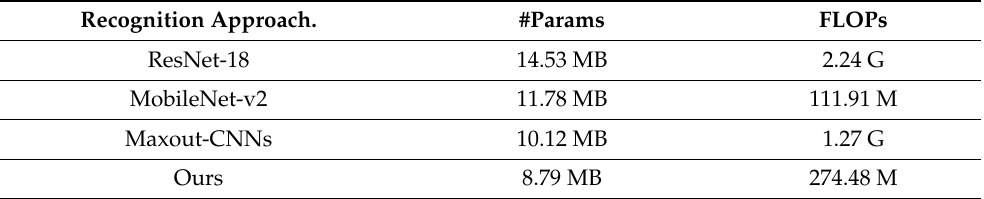
Table 5. Comparison of the number of parameters in the model architectures. Recognition